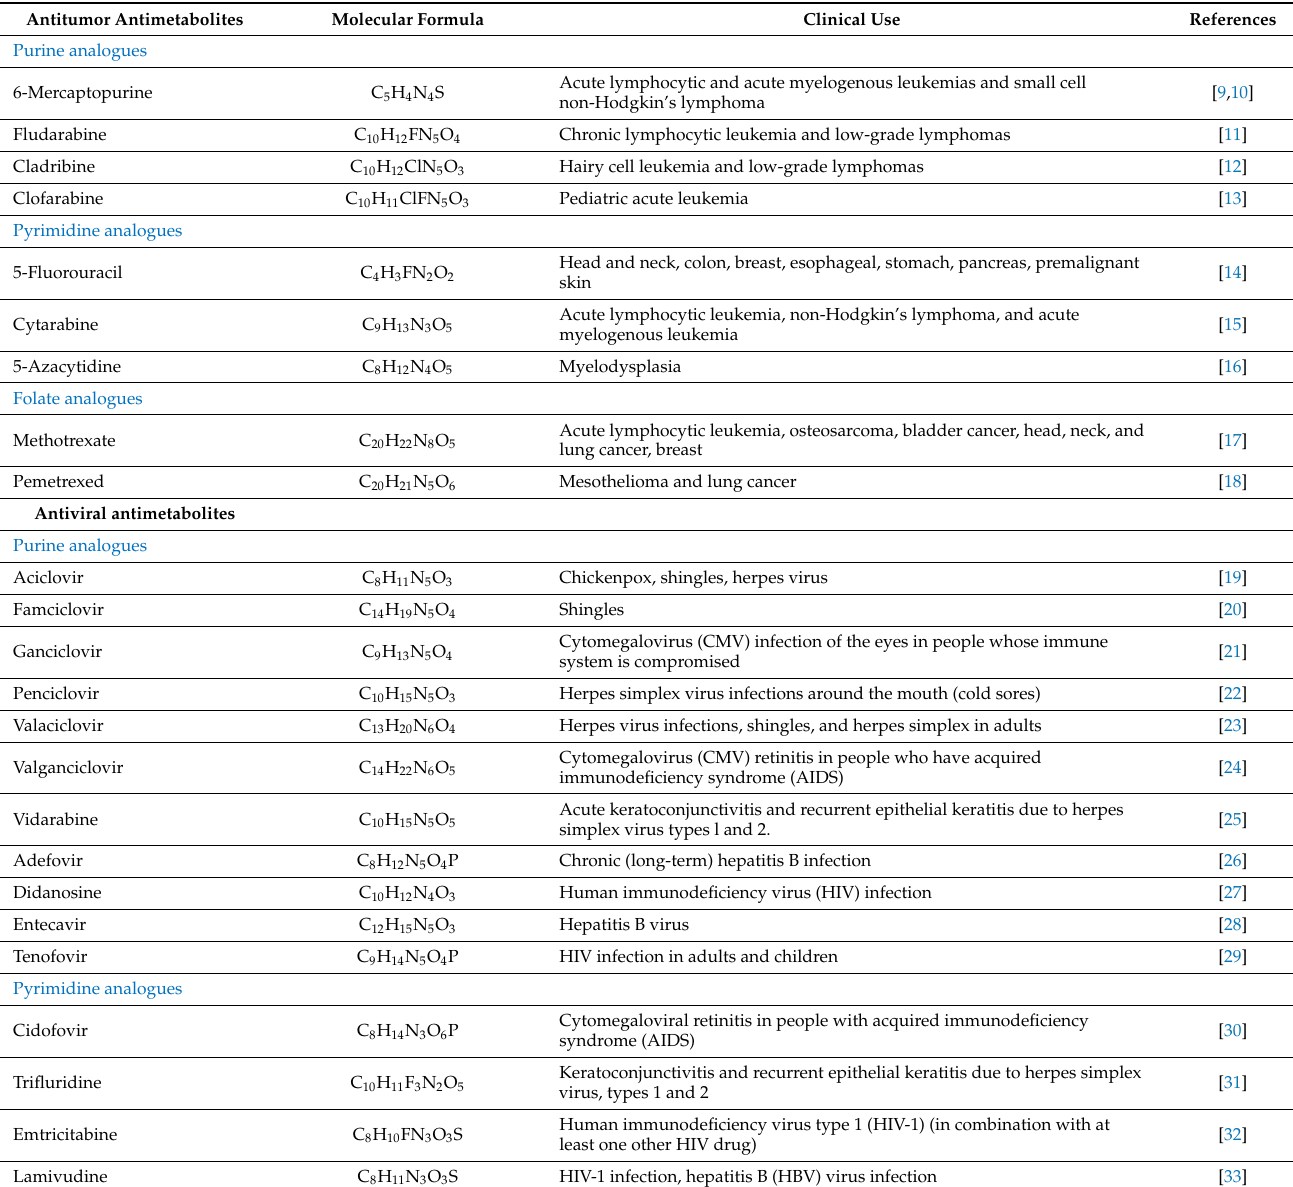
Table 1. Selection of clinically used antitumor and antiviral nucleos(t)ide analogues (NAs)